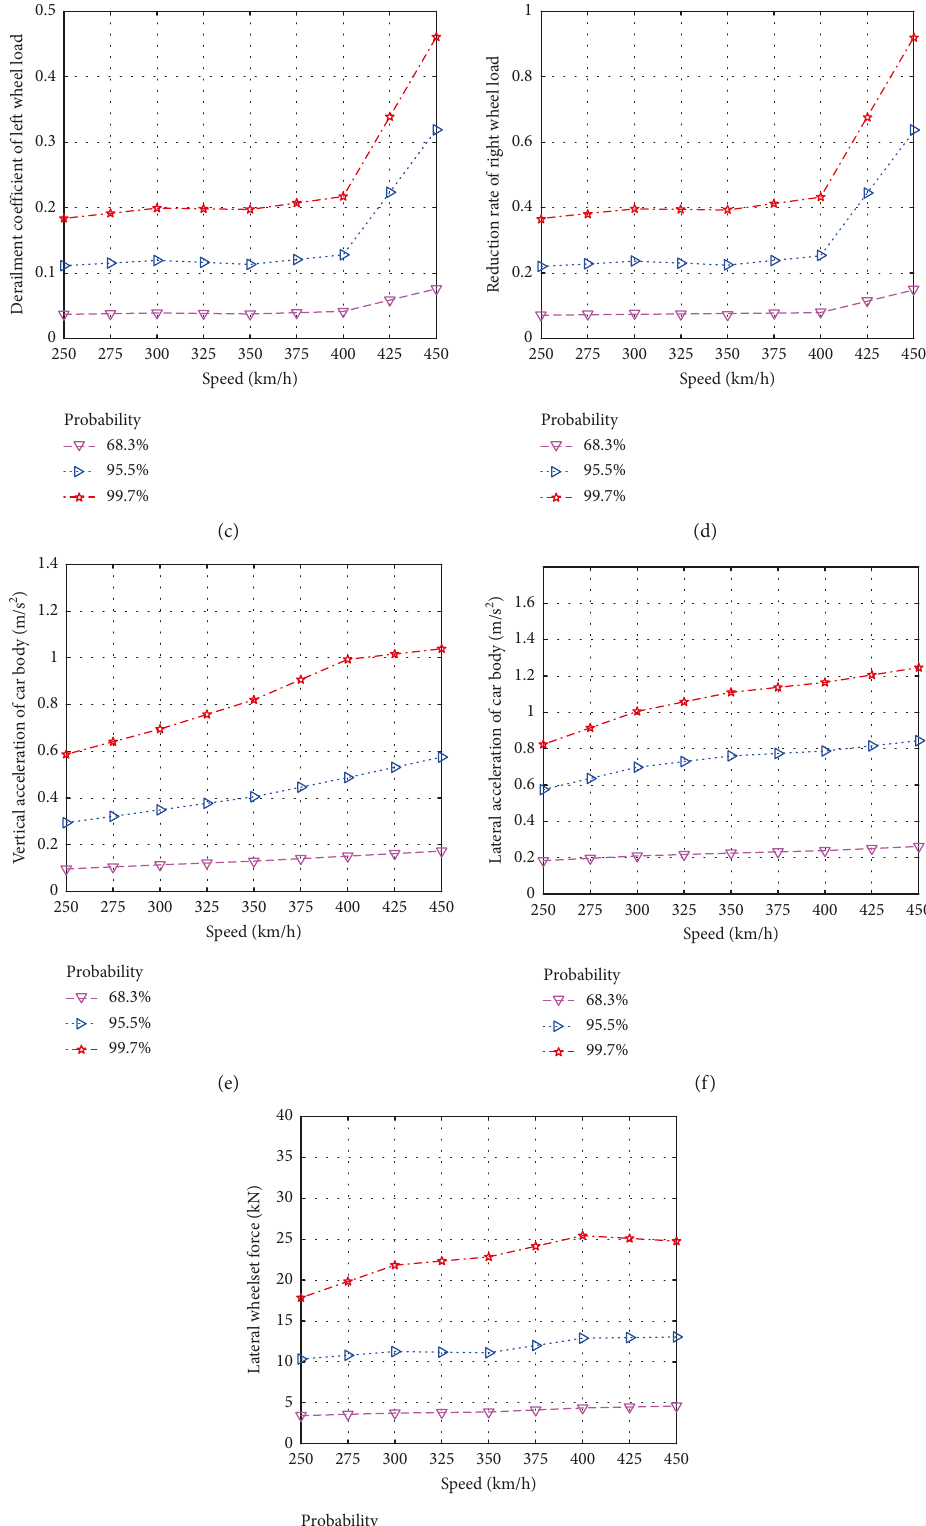
Figure 14: Speed dependences of the probabilistic train safety evaluation indices. Reduction rates of left wheel load (a) and right wheel load (b). Derailment coefficients of left wheel load (c) and right wheel load (d). Vertical acceleration of car body (e). Lateral acceleration of car body (f). Lateral wheelset force